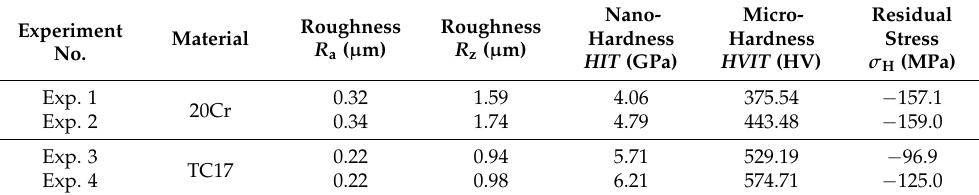
Table 6. Results of surface integrity measurements.